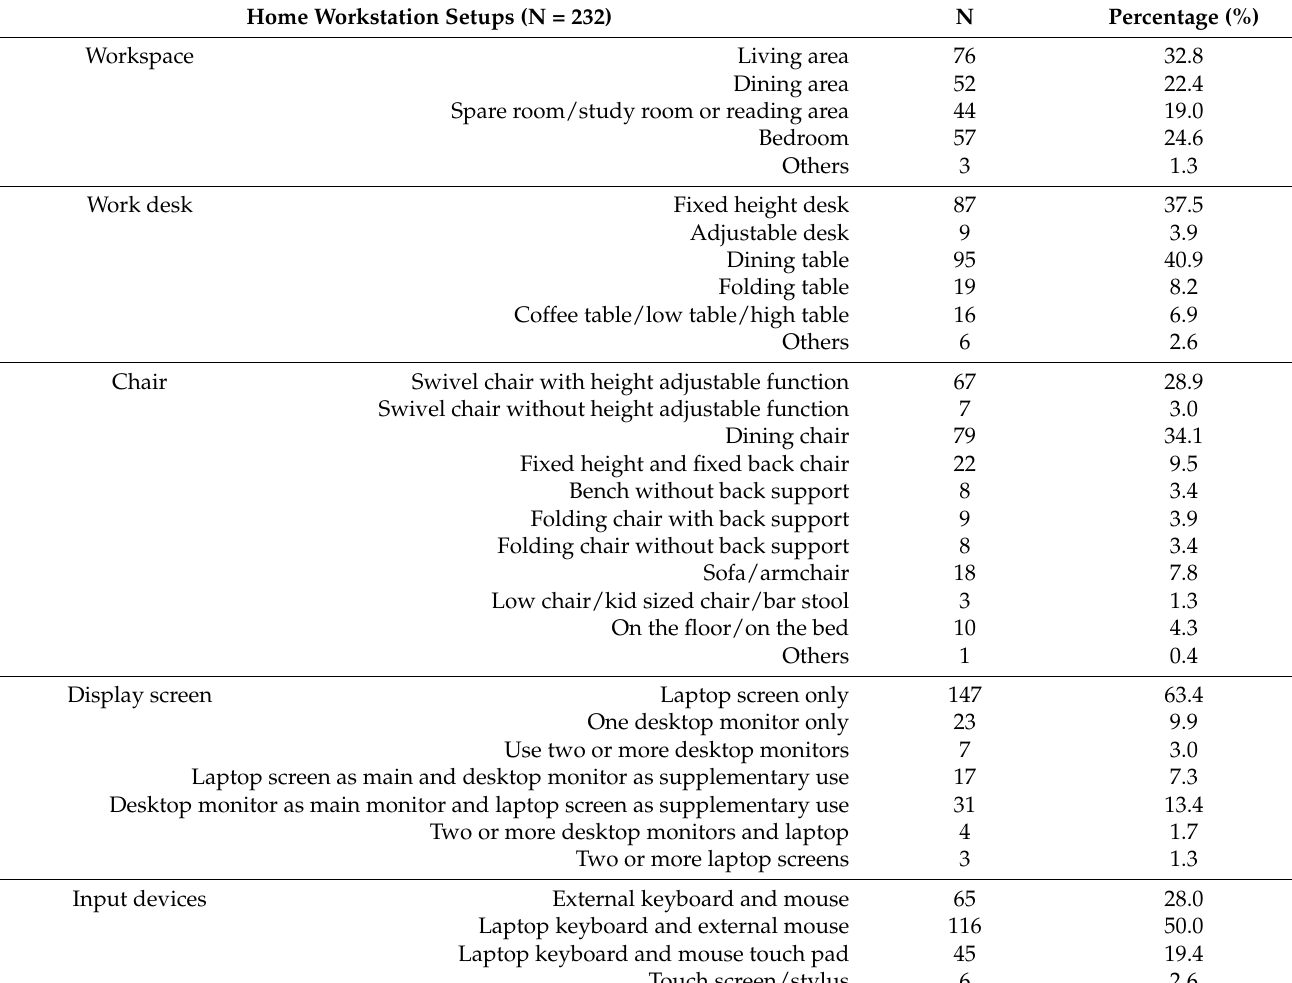
Table 4. Home workstation setups for